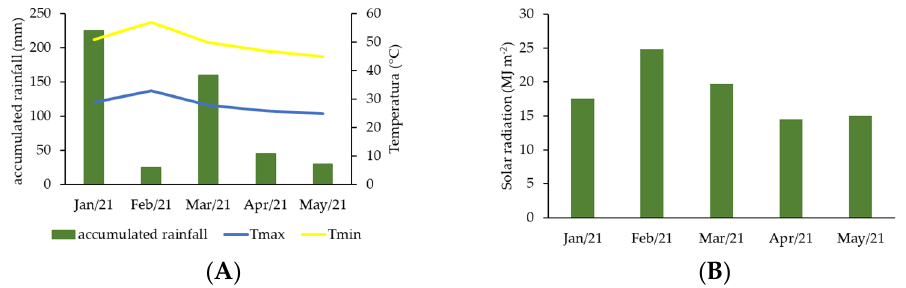
Figure 7. ( A ) Rainfall data (mm) and maximum and minimum temperature (°C) during the period of the experiment execution; ( B ) average monthly radiation data (MJ m − 2 ) during the experiment execution period in the city of São